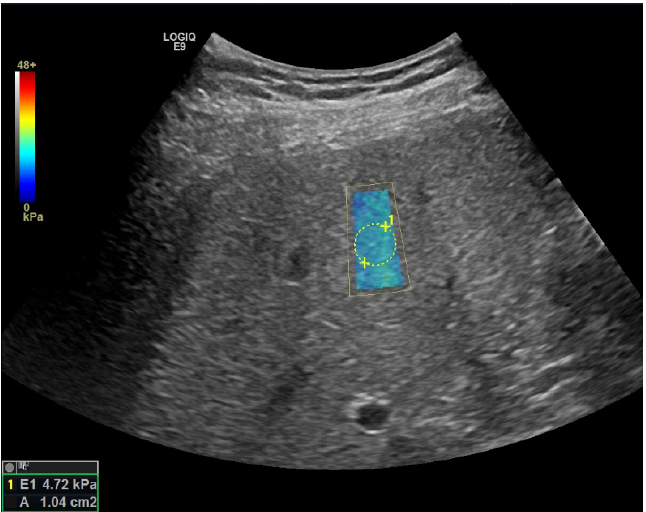
Figure 3. Representative liver stiffness measurement in a NAFLD patient with only simple steatosis. The elastogram fulfilled the quality criteria.